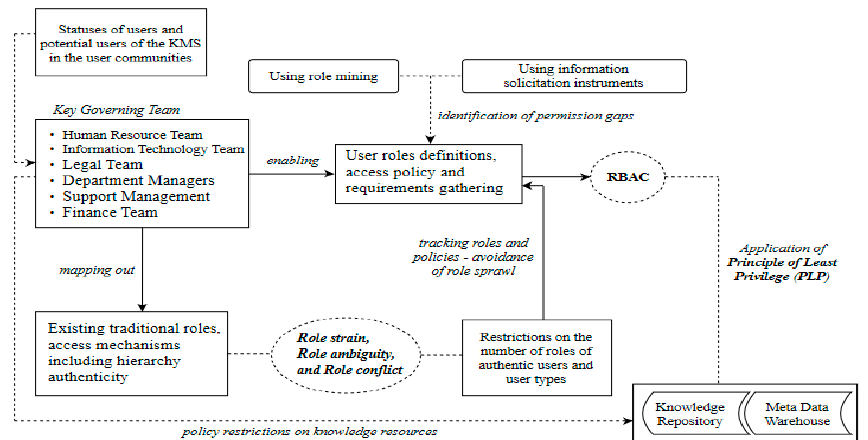
Figure 3. The precursors and their relationship with the RBAC model.